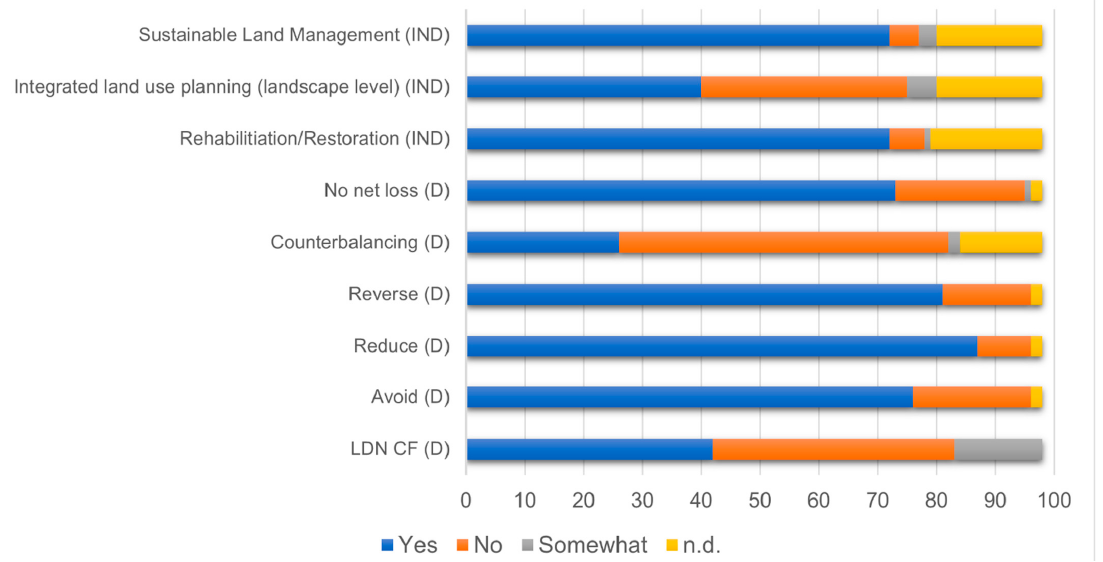
Figure 4. The result of screening 98 UNCCD GM national target reports using the direct (D) criteria applied in the scientific CF for LDN: LDN CF, response hierarchy (avoid, reduce and reverse), counterbalancing anticipated losses (offsetting expected losses/like-for-like approach, no net loss (neutrality), and the indirect (IND) criteria (rehabilitation/restoration, integrated land use planning, and sustainable land management) (see Table S6a,b for details); n.d. = no data.